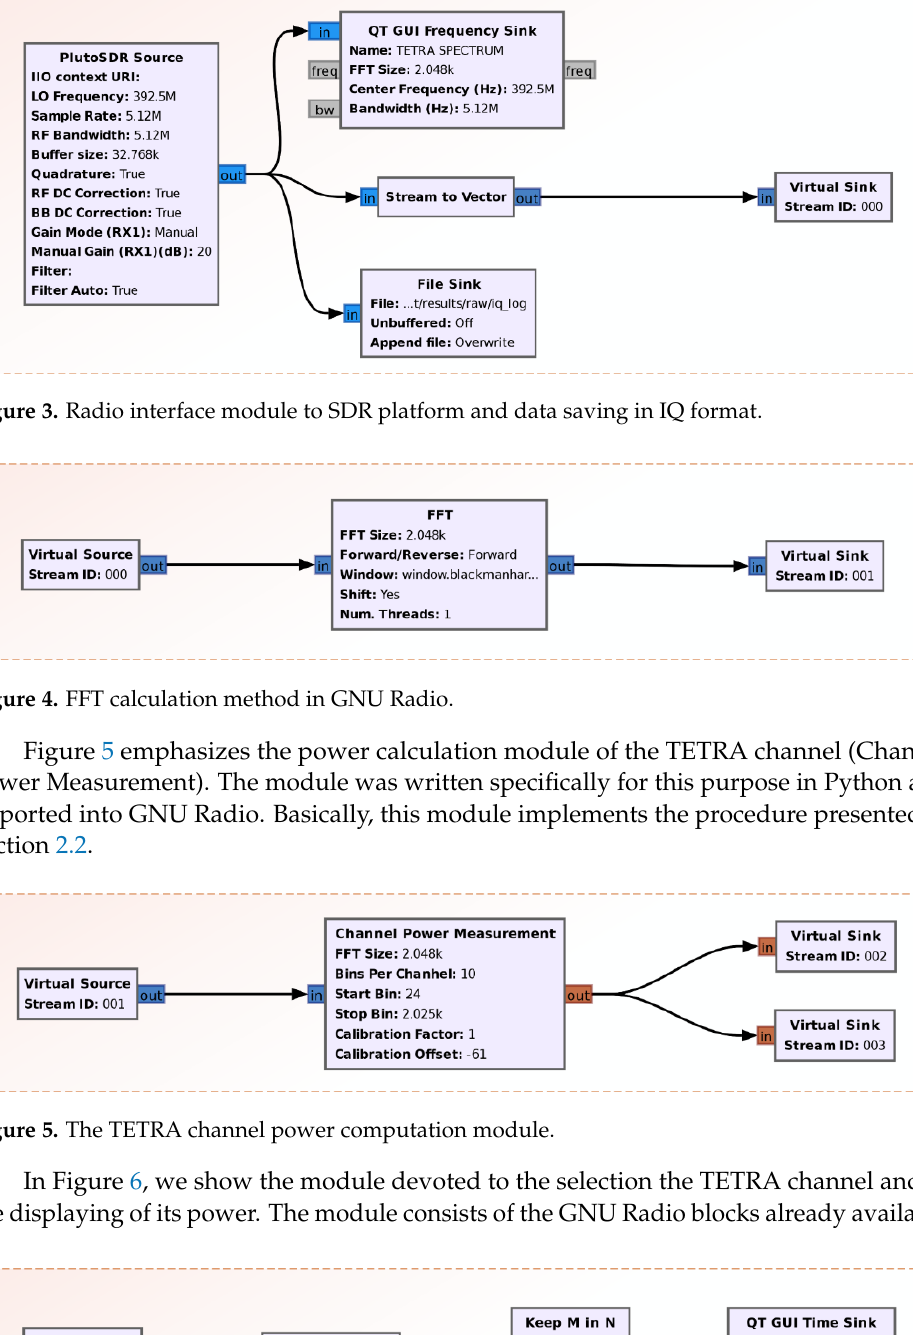
Figure 5. The TETRA channel power computation module.